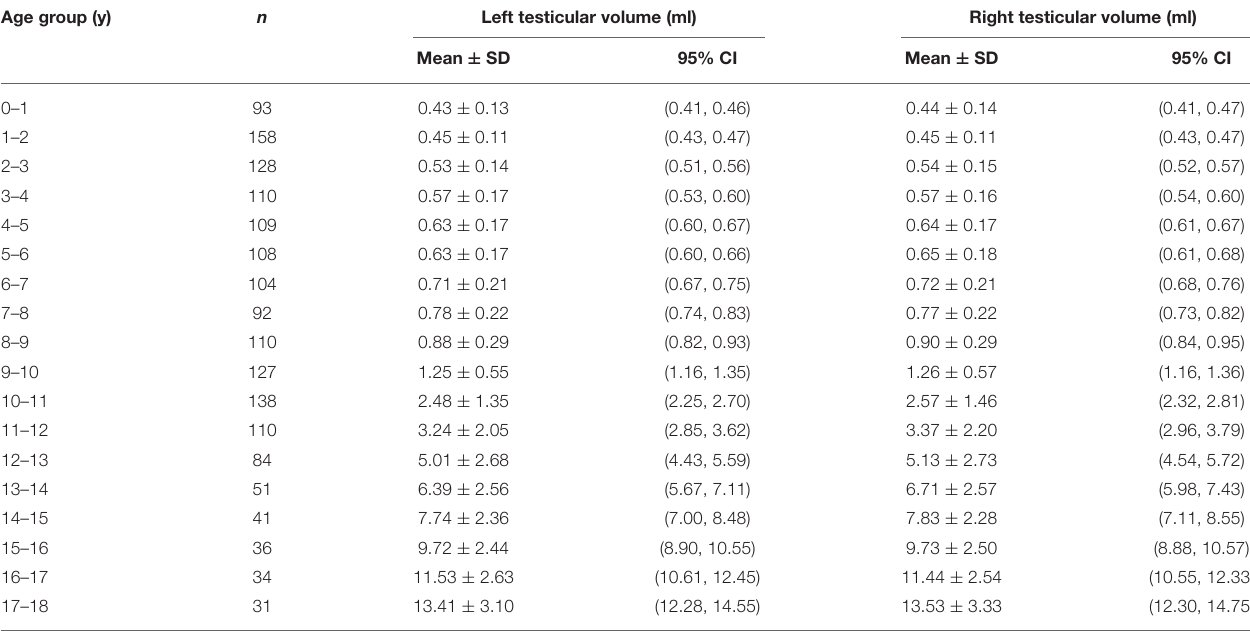
TABLE 1 | The mean, standard deviation (SD), and 95% confidence interval of mean (95%CI) derived from testicular volume(ml) in different age ranges (year). Age group (y) n Left testicular volume (ml) Right testicular volume (ml)